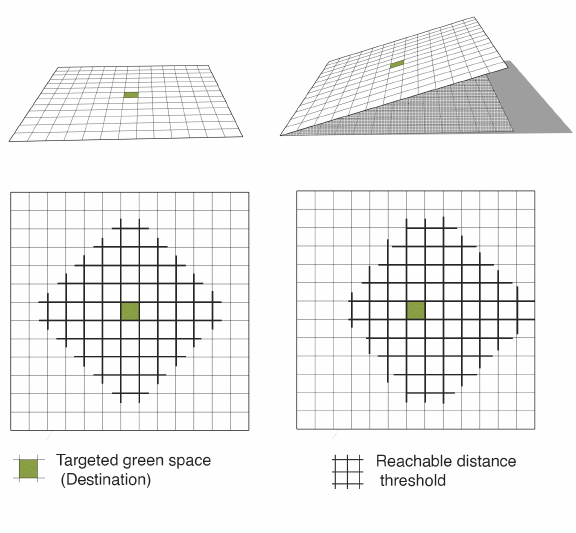
Figure 5. Schematic diagram of slope influencing on walking